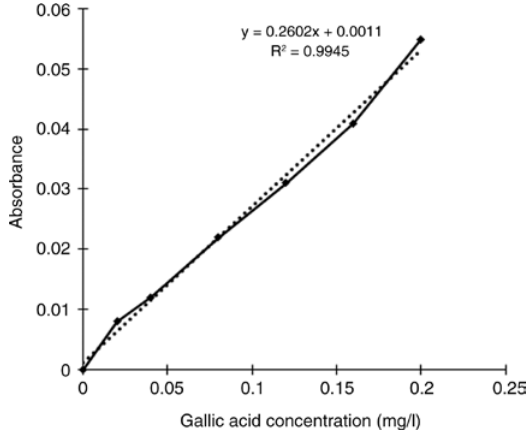
Figure 1: Calibration curve for gallic acid.